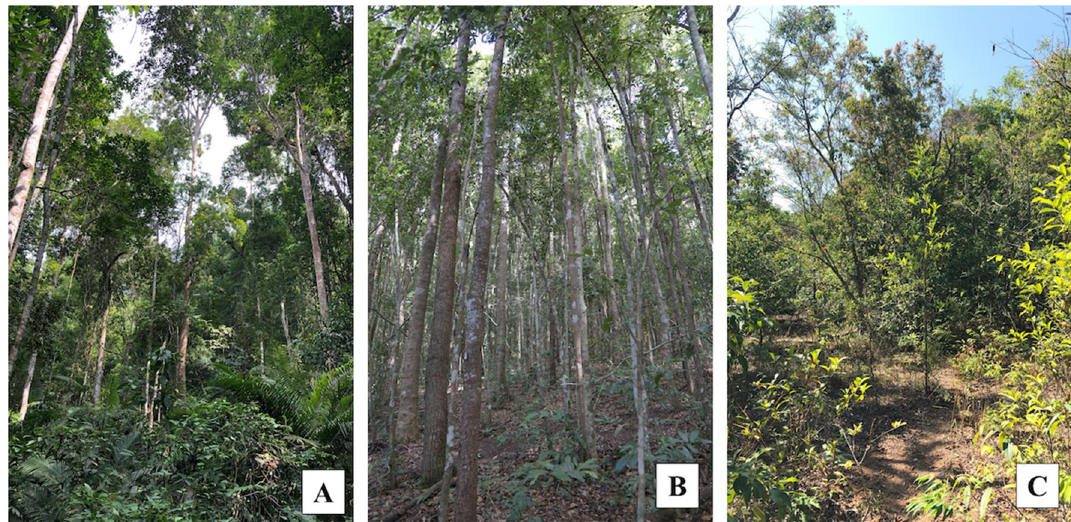
Figure 1. The studied sites in Khao Yai National Park for ( A ) old-growth forest (OF), ( B ) Intermediate forest (IF), and ( C ) Young forest